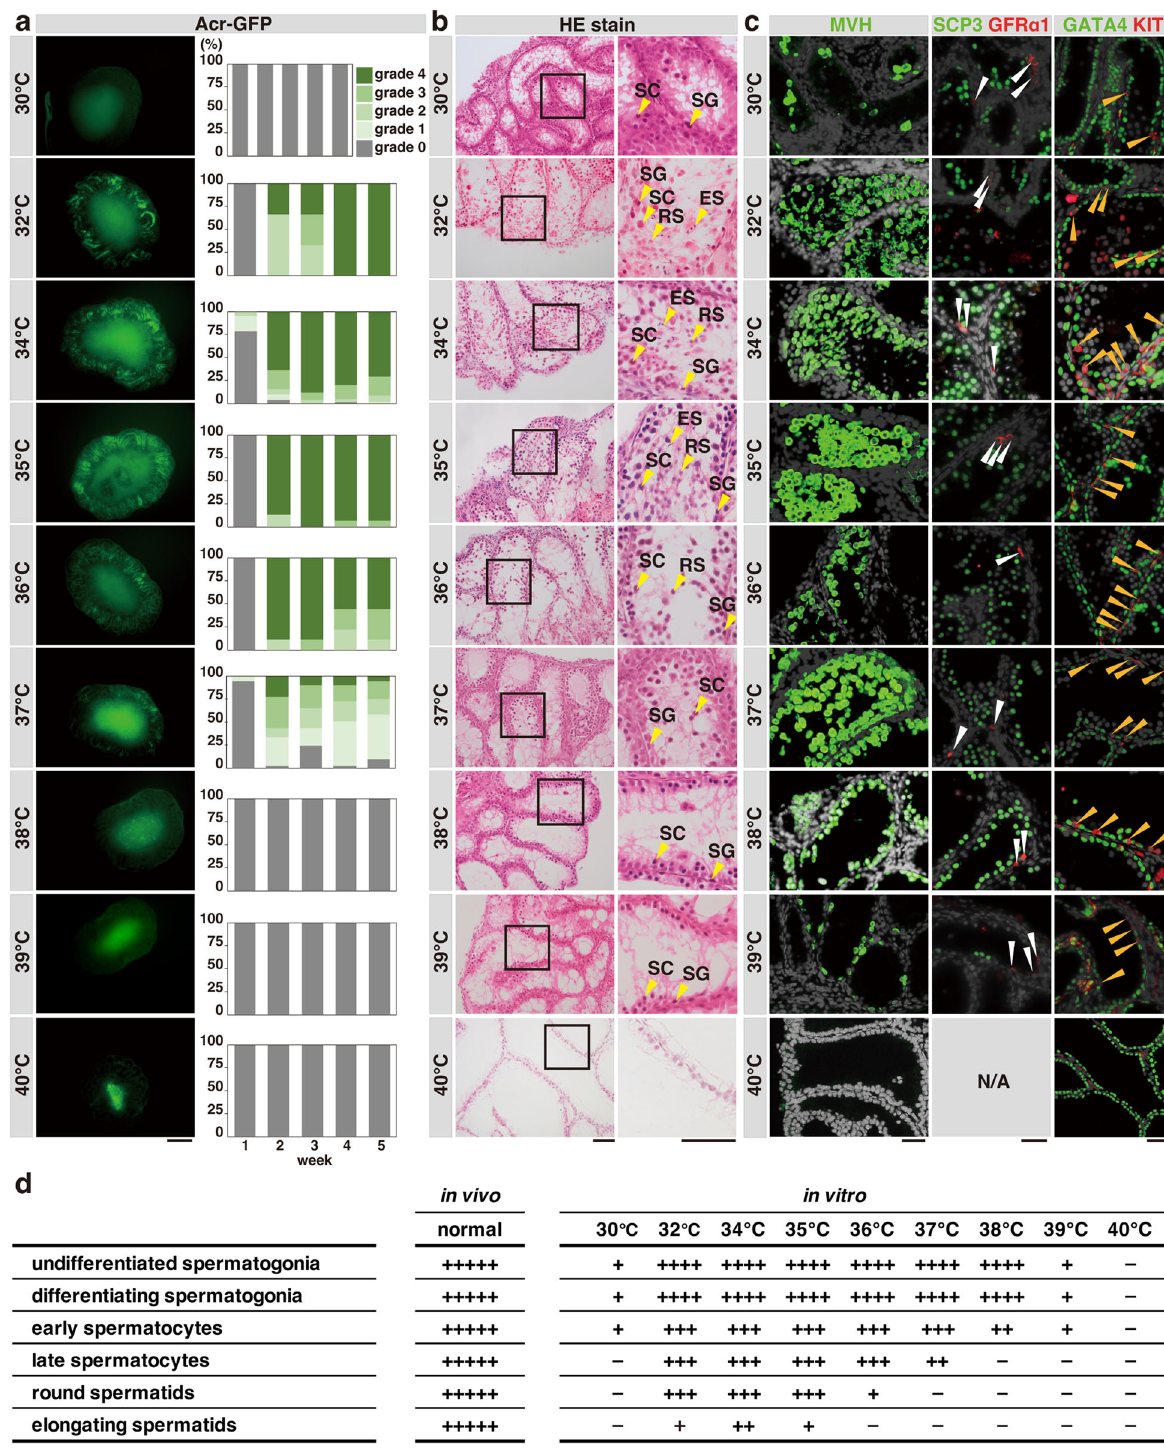
Fig. 2 Spermatogenesis progression in testis explants cultured at a range of temperatures. a Representative Acr-GFP fl uorescence images of testis explants after 5 weeks of culture at the indicated temperatures (left) and the summarized time course of Acr-GFP grades (right). N = 6, 4, 15, 9, 41, 11, and 11 for 30, 32, 35, 36, 37, 39, and 40°C, respectively. Scale bar, 500 μ m. b Representative images of HE-stained sections of testis explants cultured at the indicated temperatures. Rectangles in the left panels indicate the area magni fi ed on the right. Scale bars, 100 μ m. SG spermatogonia, SC spermatocytes, RS round spermatids, ES elongating spermatids. c Representative images of testis explant sections cultured at the indicated temperatures and immunostained for the indicated proteins. White and orange arrowheads indicate GFR α 1 + and KIT + spermatogonia, respectively. Scale bars, 40 μ m. Some panels in a – c ) are also shown in Fig. 1e, f, and g, respectively. d Summary of the qualitative evaluation of spermatogenic cell types observed in the testes explants cultured for fi ve weeks at the respective temperatures. − , never observed; + , observed infrequently but reproducibly; ++ , found easily in some peripheral tubules; +++ , observed in most peripheral tubules as a group of cells; ++++ , always observed as a robust population close to in vivo samples; +++++ , observed as a completely developed population at levels of in vivo-developed testis, which never occurred in our ex vivo